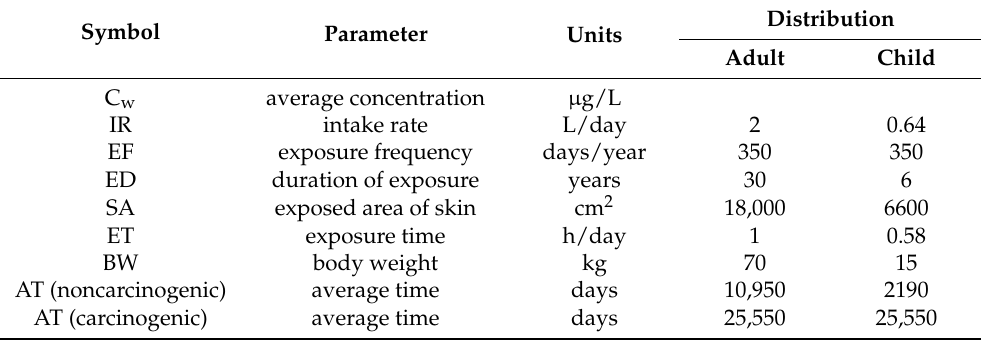
Table 1. Distributions of parameters for the health risk